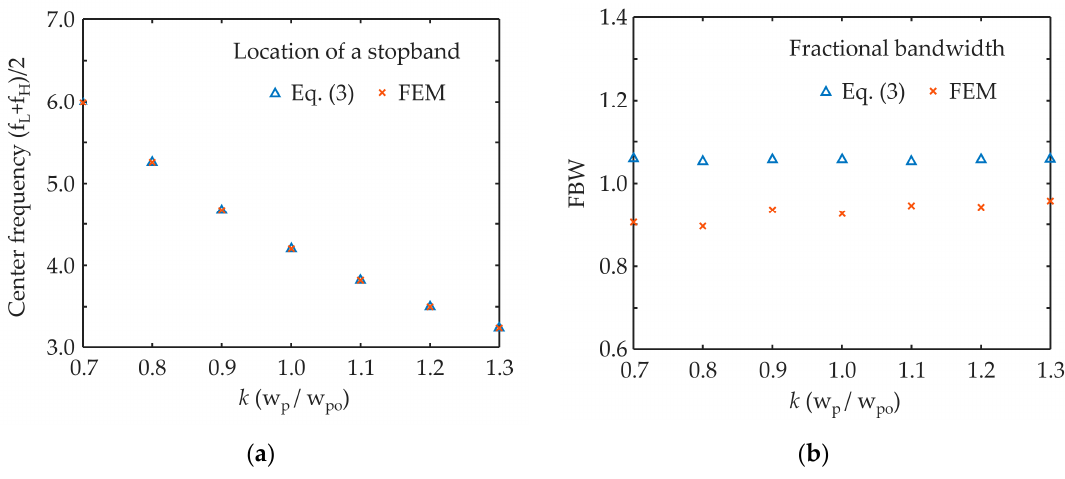
Figure 7. Analysis of the w p effects on the ( a ) center frequency and ( b ) fractional bandwidth. Table 1. Summary of the design parameter effects on the low- and high-cutoff frequencies, center frequency, and fractional